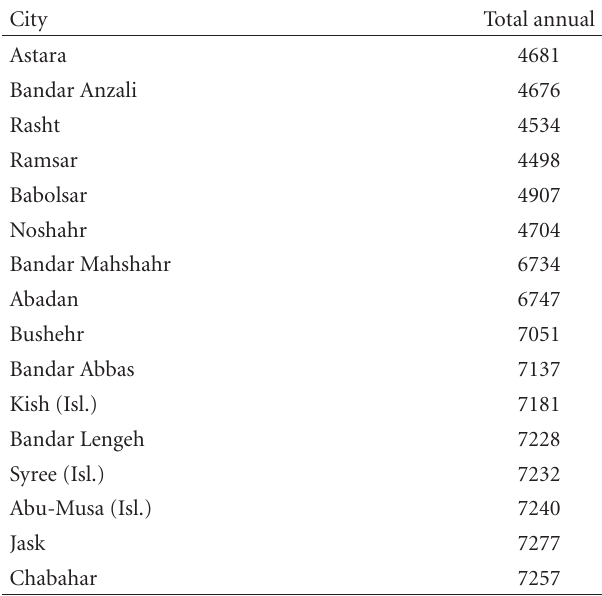
Table 5: Total annual global radiant energy at horizontal surface predicted by (MD) method. Units are in Mj